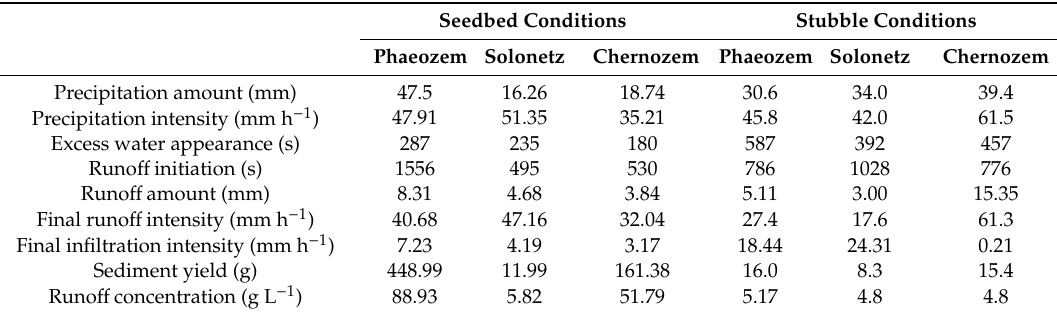
Table 2. Main measured and calculated properties of the investigated soil types.